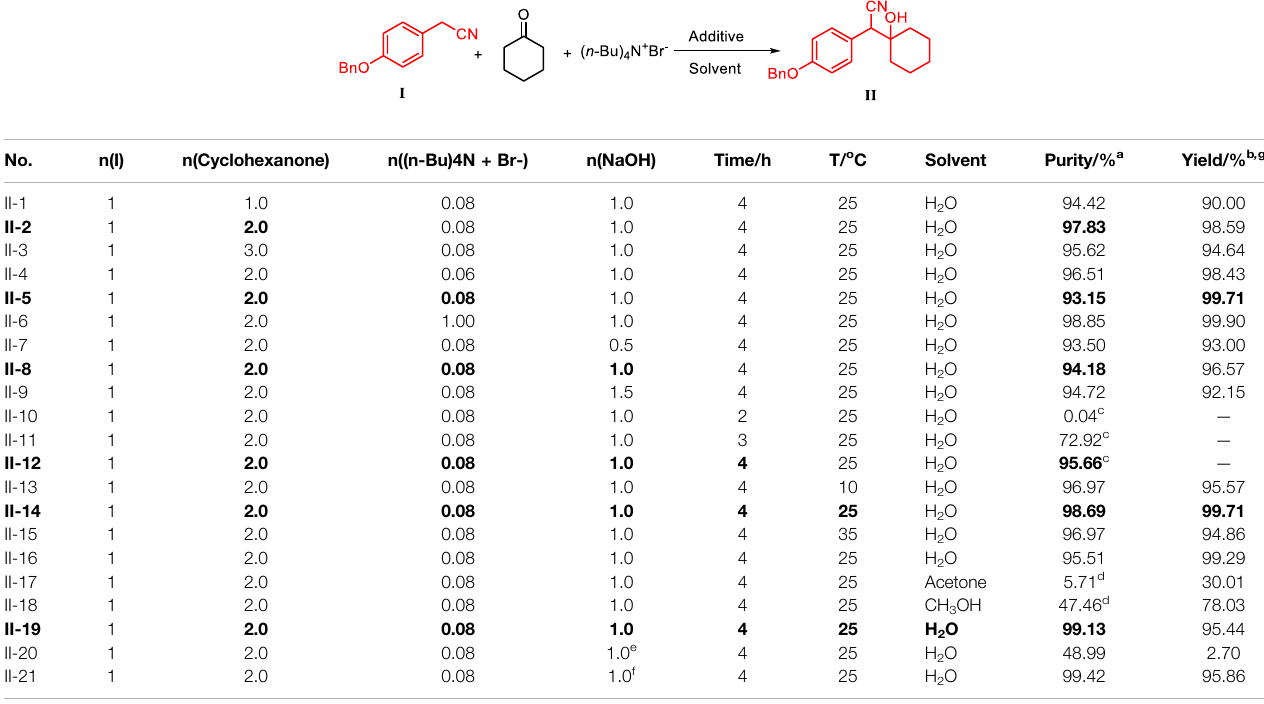
TABLE 2 | Condition optimization of Intermediate